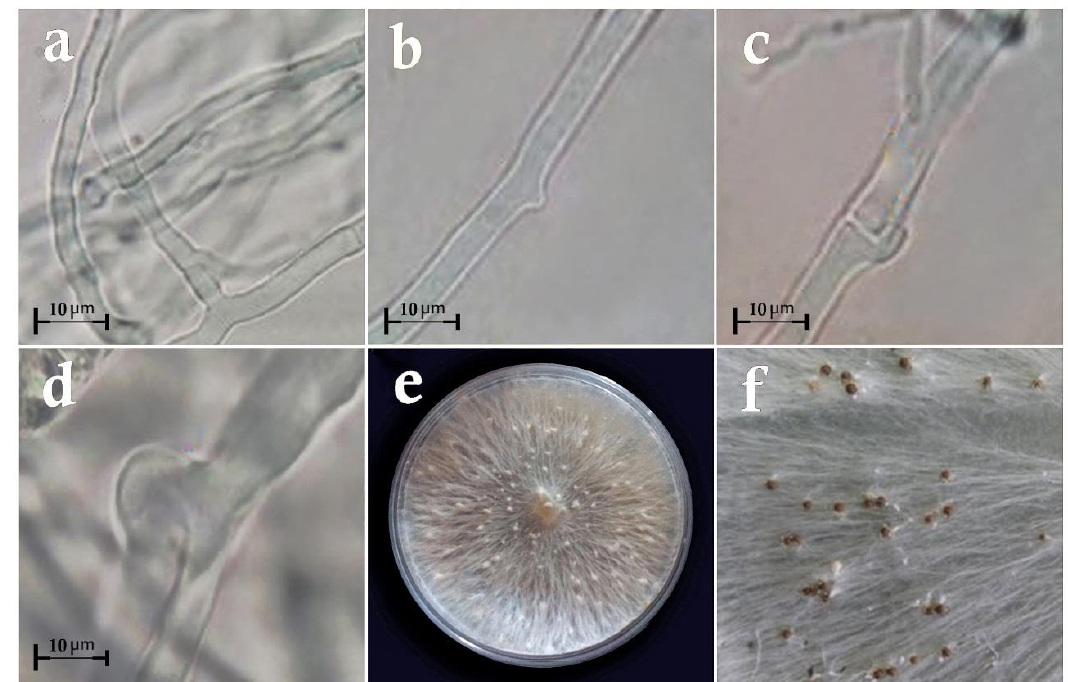
Figure 1. Microscopic images of Sclerotium rolfsii : ( a , b ) mycelia; ( c , d ) clamp connection; ( e ) mycelium distribution pattern on the PDA medium; ( f ) sclerotia formation.